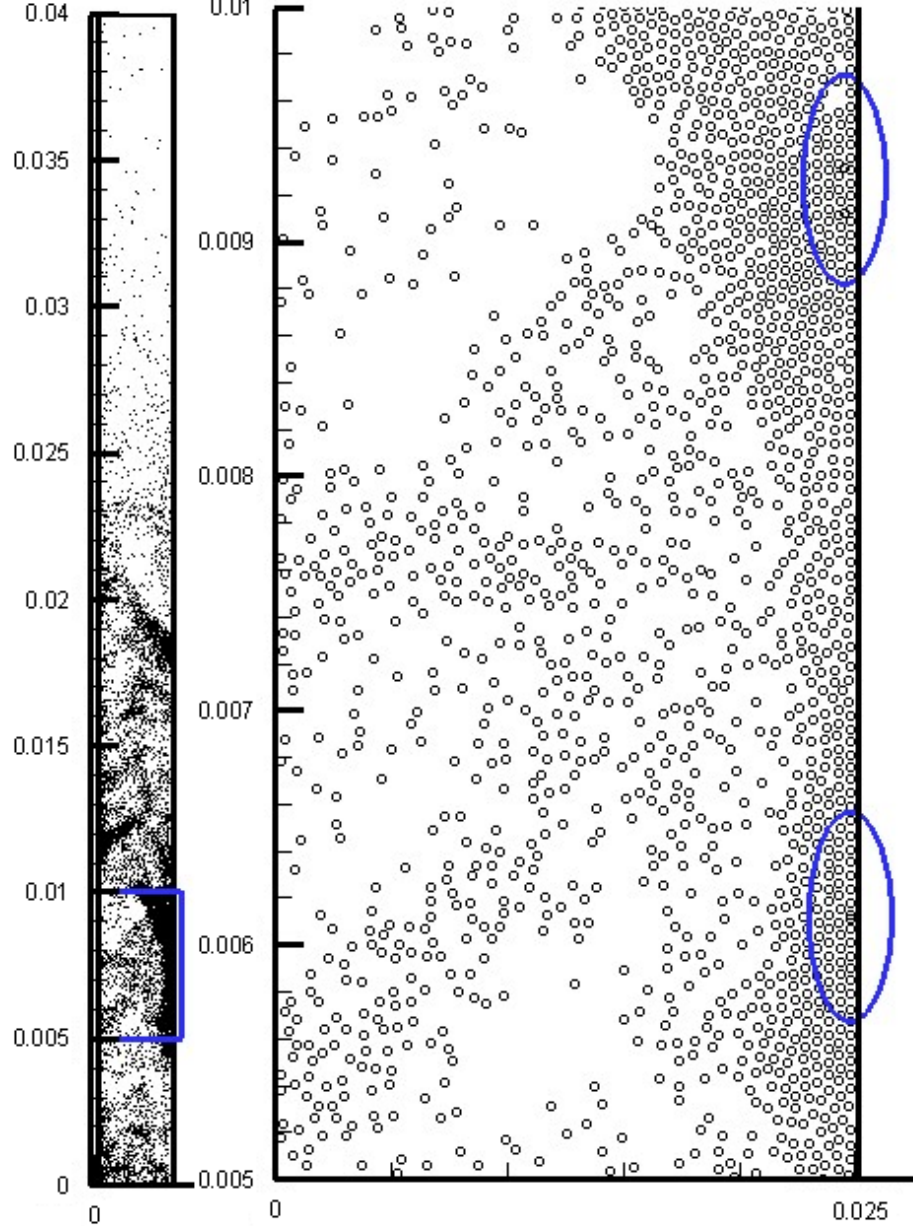
Figure 6. Particle locations at 0.074 s with over-low t r =